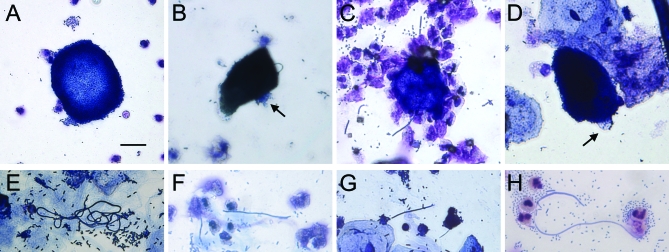
Light Microscopy Findings of Potential IBCs and Filaments in Urines from Women with CystitisLight microscopy screening of urines from cystitis patients revealed biofilm-like collections of bacteria (A), potential intracellular bacterial communities (B–D) and filamentous bacteria (E–H). Many large biofilm-like collections of small, morphologically coccoid bacteria were found in cystitis urine samples. Dark-staining epithelial cells with potential IBCs were observed often with bacteria that appear to be protruding from within (arrows). Tangled collections and individual long filamentous bacteria were also found in several of the samples. Scale bar, 20 μm, applies to all photomicrographs.